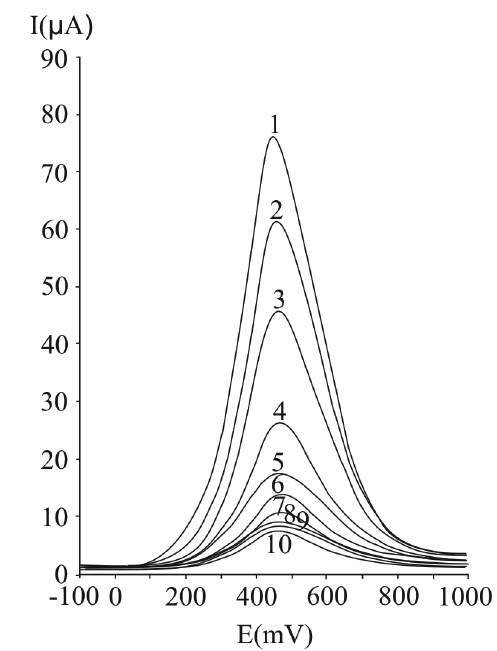
Figure 3: Differential pulse voltammograms obtained at a carbon paste working electrode for different ascorbic acid concentrations, expressed as mM: 20 (1), 15 (2), 10 (3), 5 (4), 2.5 (5), 1.25 (6), 0.625 (7), 0.31 (8) 0.15 (9) and 0.07 (10); 0.1 M KCl solution was used as supporting electrolyte